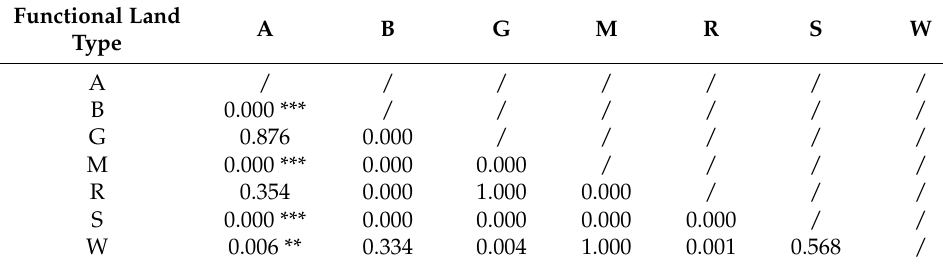
Table 5. Dunn test of DST with Holm-Bofferoni correction among